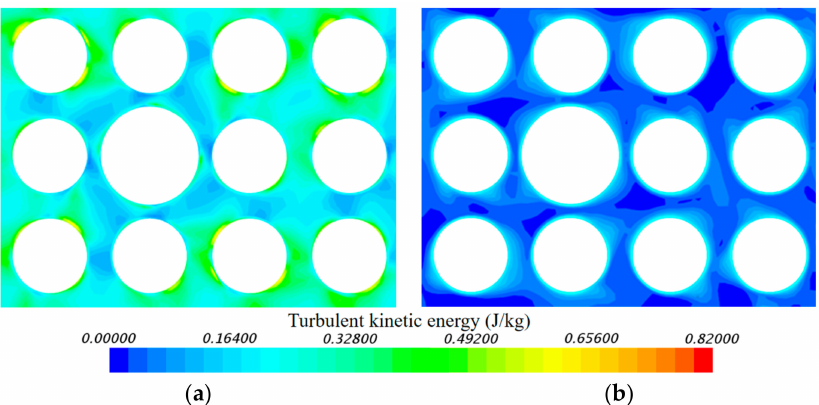
Figure 20. Turbulent kinetic energy in the plane downstream of the third mixing grid: ( a ) 5 mm downstream of the grid and ( b ) 400 mm downstream of the grid.